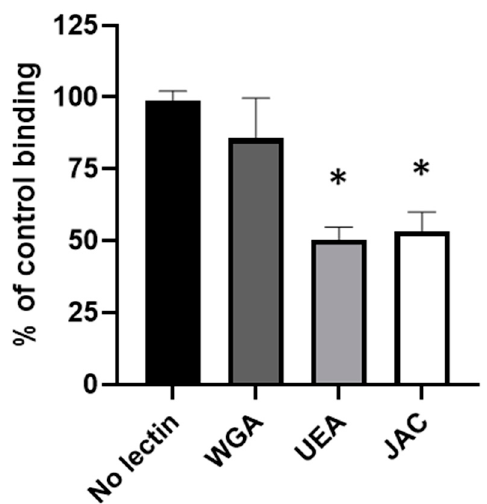
Figure 8. Lectins binding Galactose and N-acetyl-Galactosamine inhibit the interaction of GST-RadA 35-252 with type II mucin. Coated type II mucin (coated at 4 pmol per wells (40 nM)) was pre-incubated with various lectins: Wheat Germ Agglutinin (WGA, specific for GlcNAc), Ulex Europaeus Agglutinin (UEA, specific of Gal) and Jacalin (JAC, specific of Gal and GalNAc) (all at 100 µg/mL). A solid-phase binding assay of GST-RadA 35-252 was then conducted as explained in Materials and Methods. Results are expressed as means ± S.D. *: p < 0.01 ( n = 3).